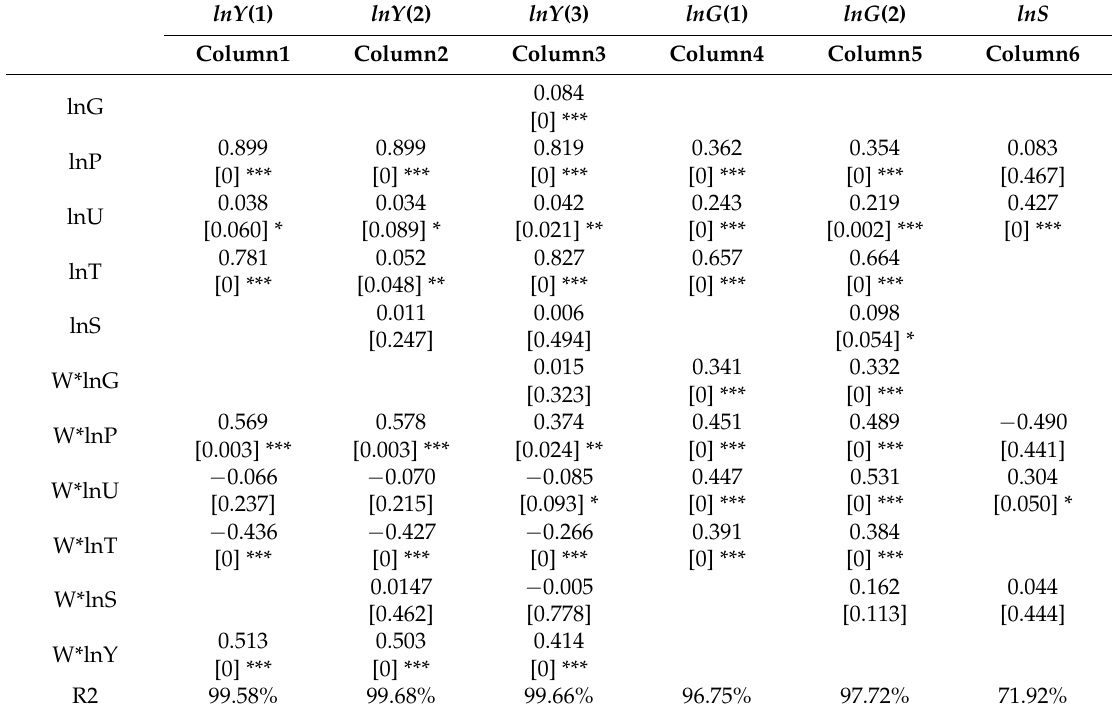
Table 8. The chain for intermediary test results of Urbanization ( lnU ) → Social Employment Level ( lnS ) → Economic Development Level ( lnG ) → Carbon Emission ( lnY ).